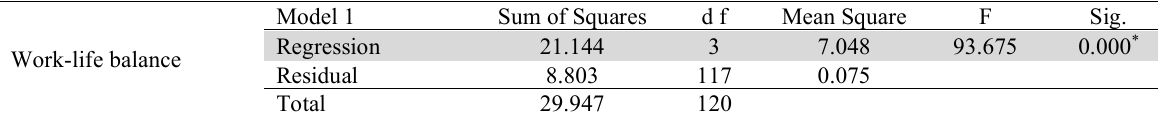
The summary of the results of ANOVA test Work-life balance